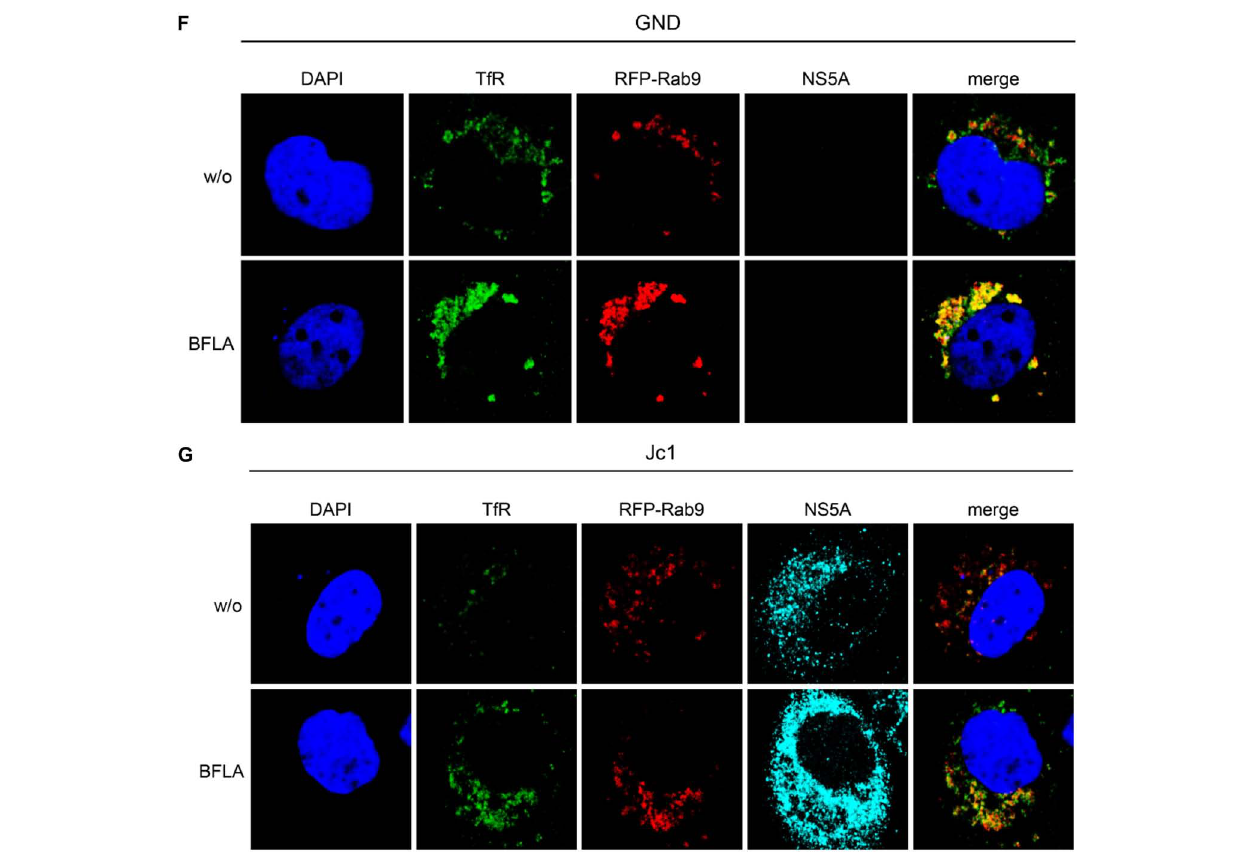
FIGURE 4 | Colocalization of the TfR with LAMP-2 positive structures. (A) CLSM analysis of HCV-positive Huh7.5 cells (Jc1). The cells were stained using NS5A- (cyan), TfR- (green), and LAMP-2-specific (red) antibodies. Nuclei were stained with DAPI (blue). Laser intensity and digital gain were kept constant. Magnifications, x100. Scale bar represents 5 µ m. (B) Higher magnification of the indicated areas (white squares) of A depicting HCV-positive (Jc1) and HCV-negative cells (GND). NS5A (cyan), TfR (green), and LAMP-2 (red). Nuclei were stained with DAPI (blue). Scale bar represents 5 µ m for the upper lane and 2 µ m for the lower lane, respectively. White arrows indicate the close association of TfR to the lysosomal marker LAMP-2. (C) CLSM analysis of HCV-positive Huh7.5 cells (Jc1) treated with BFLA (50 nM) for 16 h. The cells were stained using NS5A- (cyan), TfR- (green), and LAMP-2-specific (red) antibodies. Nuclei were stained with DAPI (blue). Laser intensity and digital gain were kept constant for untreated and BFLA-treated cells. Magnifications, x100. Scale bar represents 10 µ m. (D) Higher magnification of the indicated areas (white squares) of C depicting HCV-positive (Jc1) and HCV-negative cells (GND) treated with BFLA (50 nM) for 16 h. NS5A (cyan), TfR (green), and LAMP-2 (red). Nuclei were stained with DAPI (blue). Magnifications, x100. Scale bar represents 5 µ m for the upper lane and 2 µ m for the lower lane. White arrows mark the close association of TfR to the lysosomal marker LAMP-2 after BFLA-treatment. (E) Quantification of the fluorescence intensity of TfR and LAMP-2 in lysosomal structures of untreated and BFLA-treated HCV-negative (GND) and HCV-positive cells (Jc1) ( n = 2, mean ± SEM). (F) CLSM analysis of HCV-negative (GND) and (G) HCV-positive (Jc1) Huh7.5 cells. The cells were treated with BFLA (50 nM) for 16 h and stained using NS5A- (cyan) and TfR- (green)-specific antibodies; Rab9-RFP transfected cells are in red. Nuclei were stained with DAPI (blue). Laser intensity and digital gain were kept constant. Magnifications,